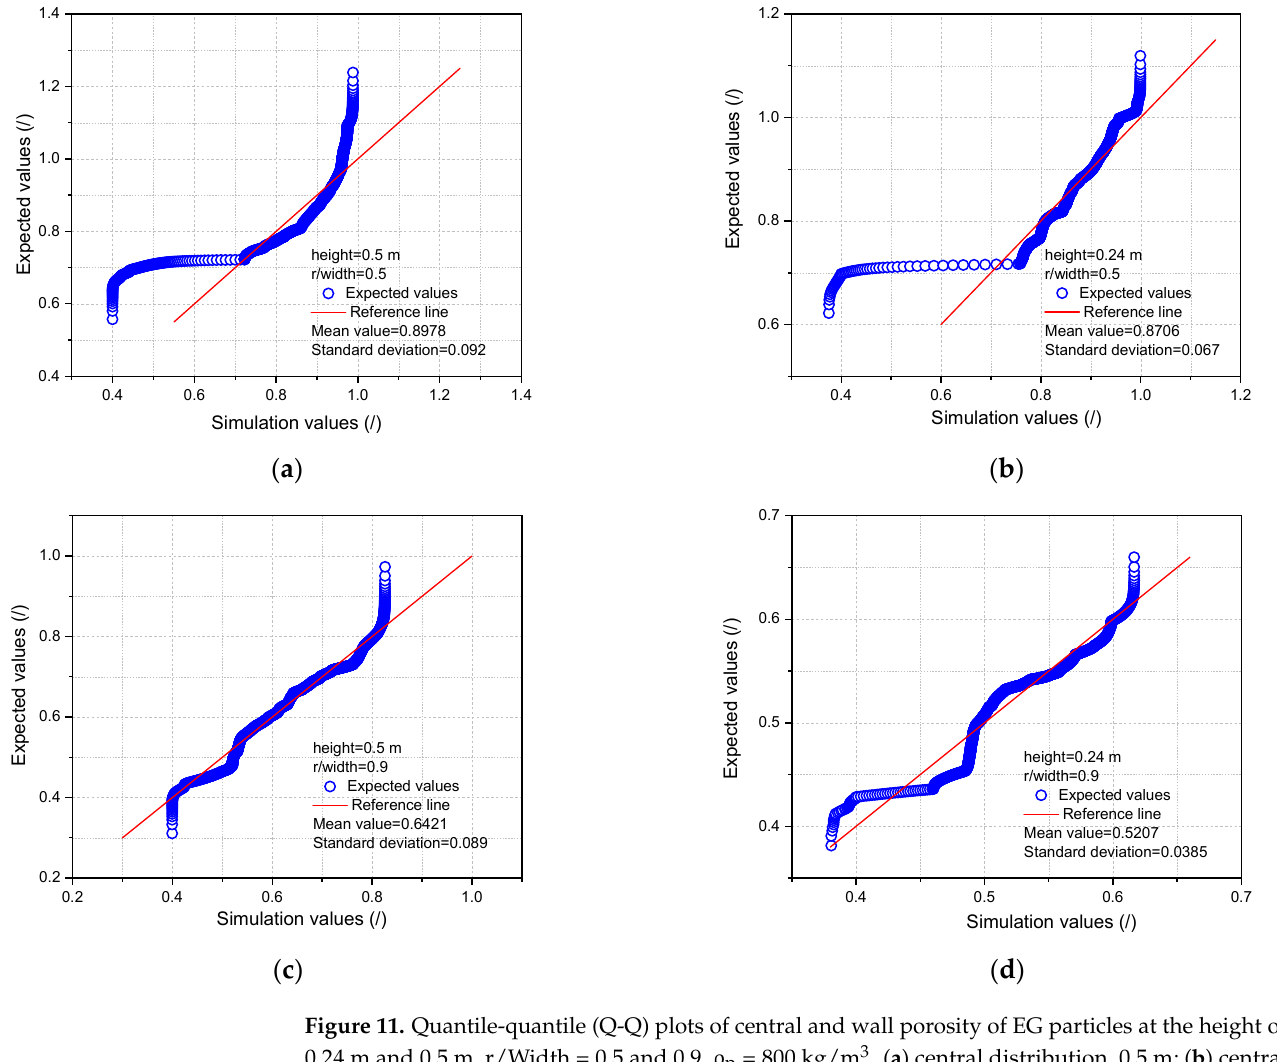
( d ) Figure 12. Quantile-quantile (Q-Q) plots of central and wall porosity of particles used in experiment at the height of 0.24 m and 0.5 m, r/Width = 0.5 and 0.9, ρ p = 2700 kg/m 3 . ( a ) central distribution, 0.5 m; ( b ) central distribution, 0.24 m; ( c ) wall distribution, 0.5 m; ( d ) wall distribution, 0.24 m.